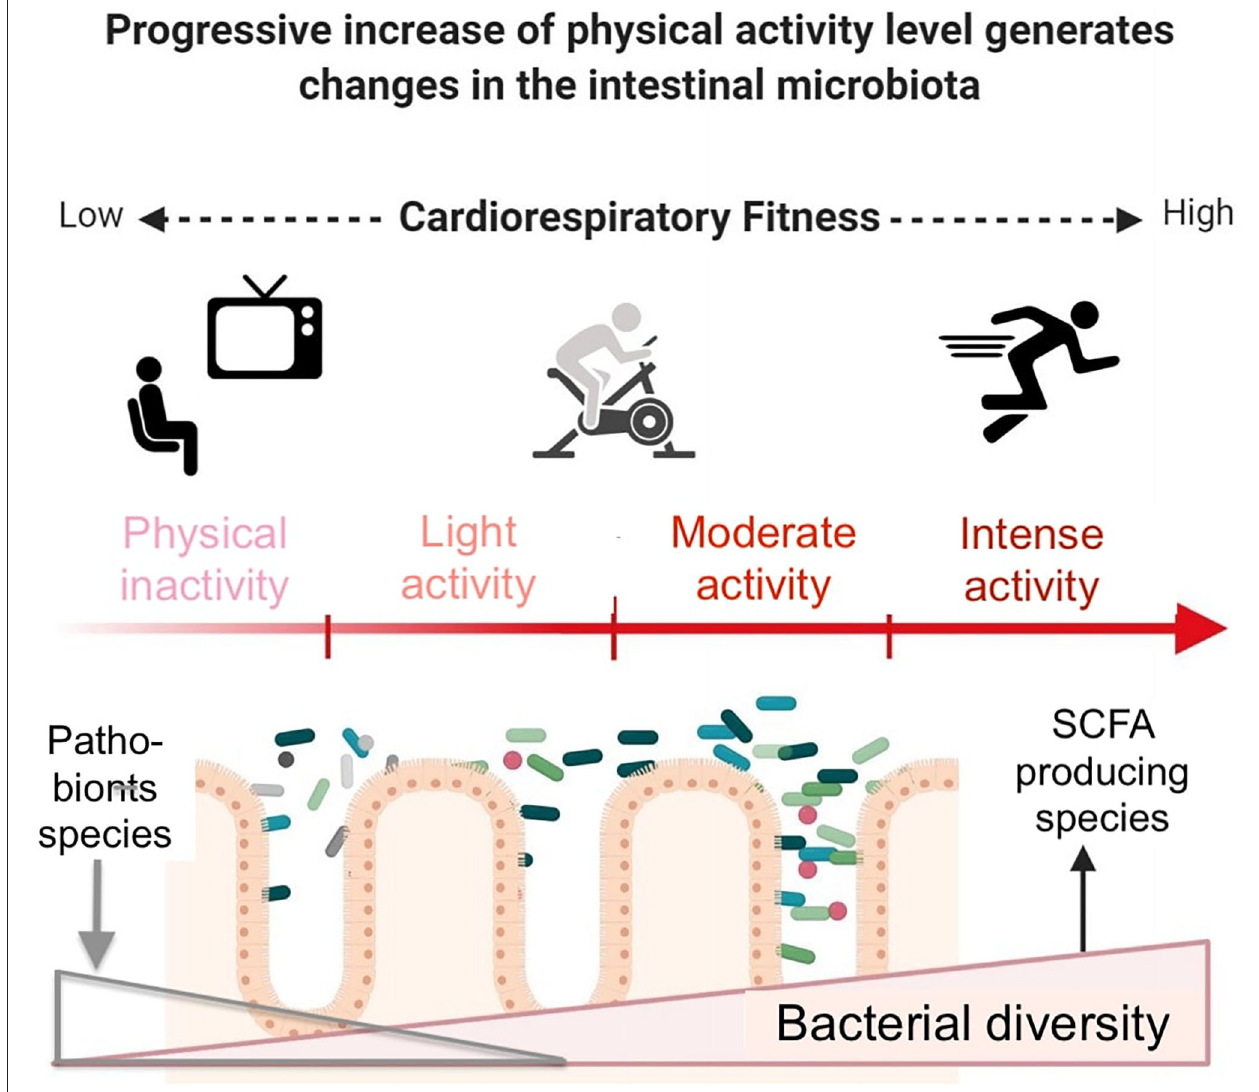
FIGURE 1 | Beneficial effects of exercise and gut microbiota modifications in inactive subjects. Exercise induces beneficial molecular adaptations allowing the enhancement of cardiorespiratory fitness. Bacterial diversity increases, including SCFA- producing species. Conversely, pathobionts such as E. coli or E. faecalis , potentially disease-causing species which, under normal circumstances, are found as a non-harming symbiont, decrease. Longitudinal studies monitoring exercise intensity and modality, diet, subjects’ characteristics and gut microbiota are still lacking. Modified from Aya et al. (40), with